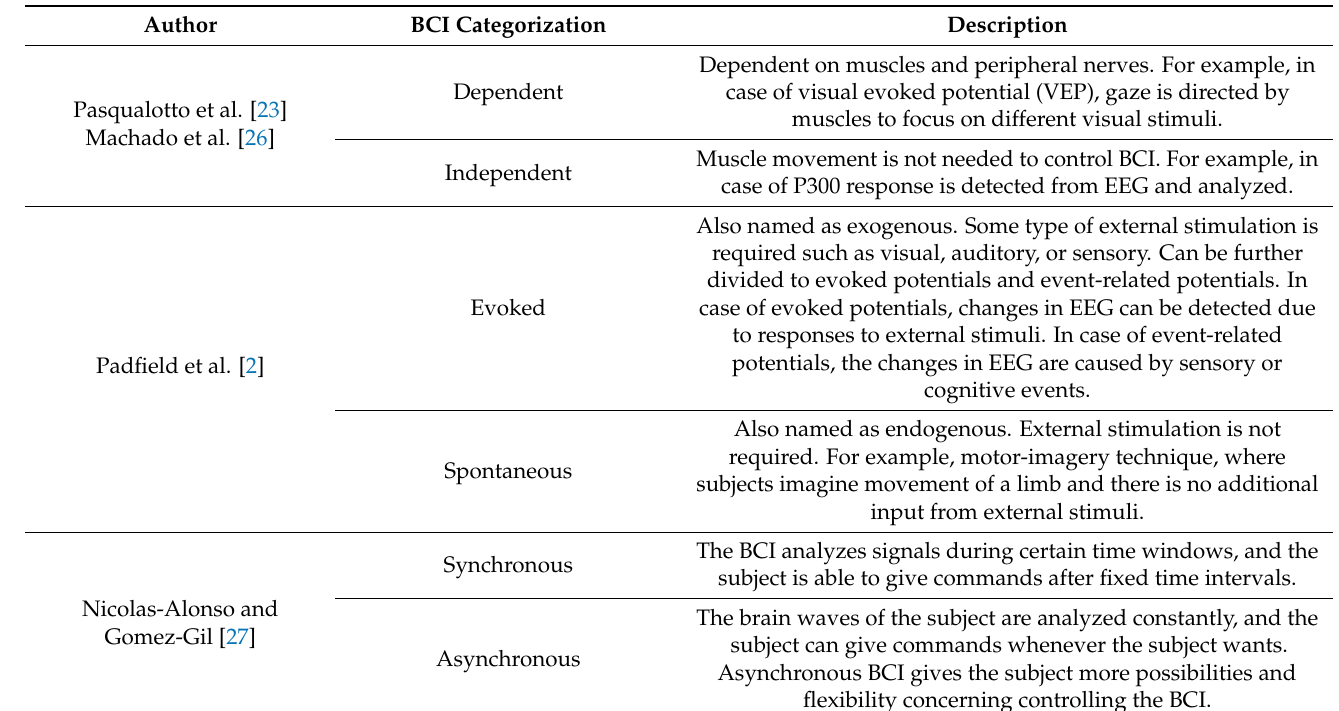
Table 2. Additional different categorization of the BCIs in the literature by Pasqualotto et al.